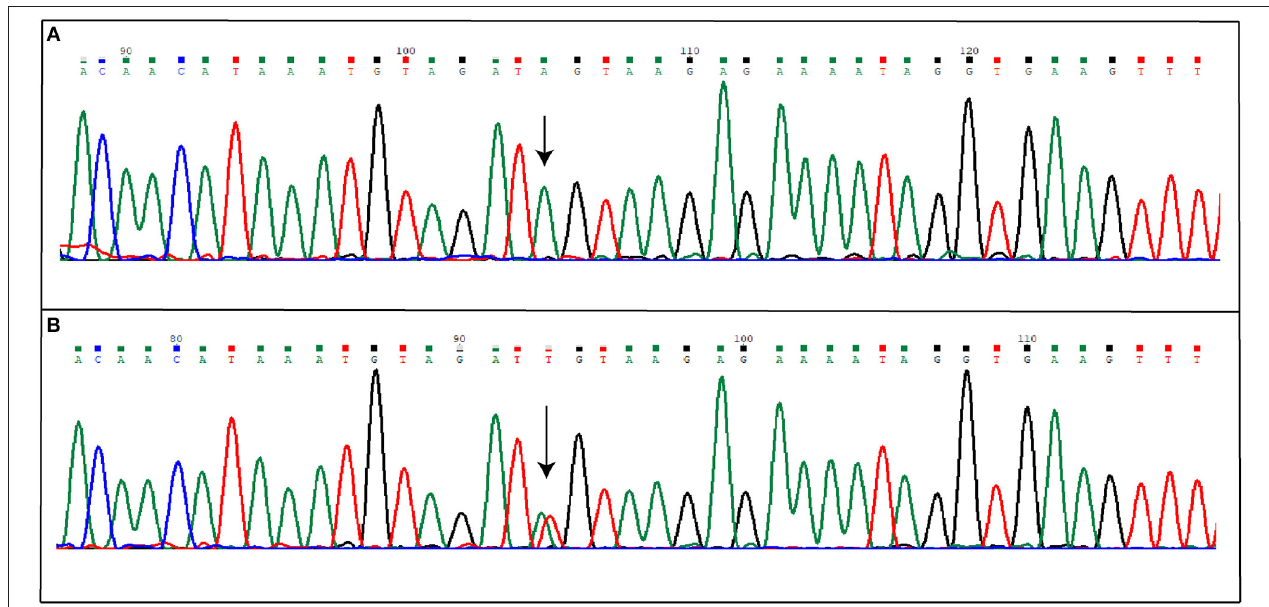
FIGURE 3 | Novel IVS15-66A > T mutation detected in KRIT1 gene. The figure shows both wild-type (A) and mutated (B) electropherograms. The heterozygous substitution is indicated by the arrow.